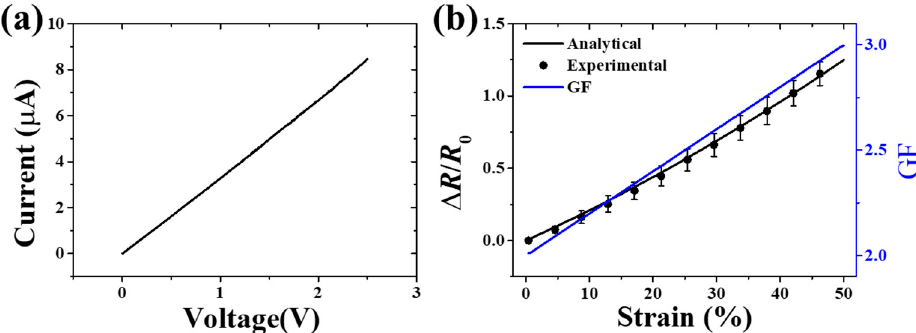
Figure 7. ( a ) I-V test of the EES. ( b ) The results of resistance change ratio and GF under the applied strain of up to 50%.